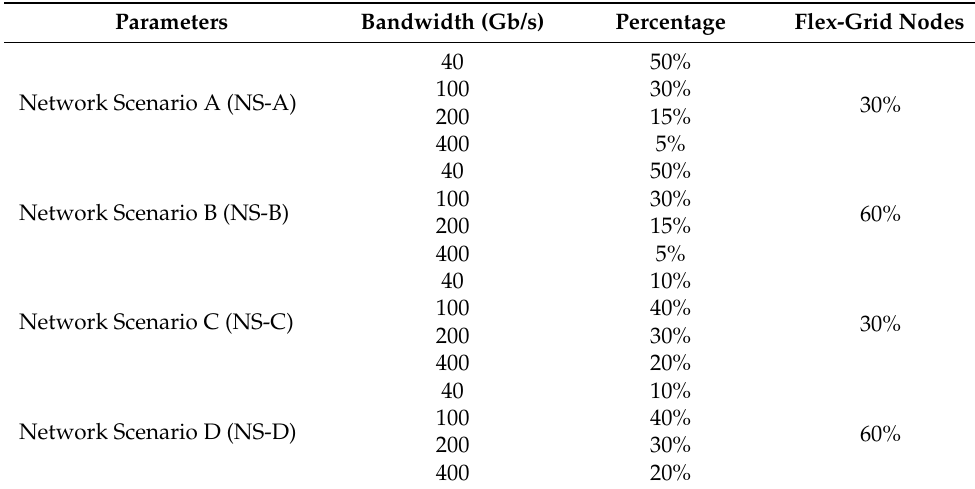
Table 2. Parameters in different Network Scenarios